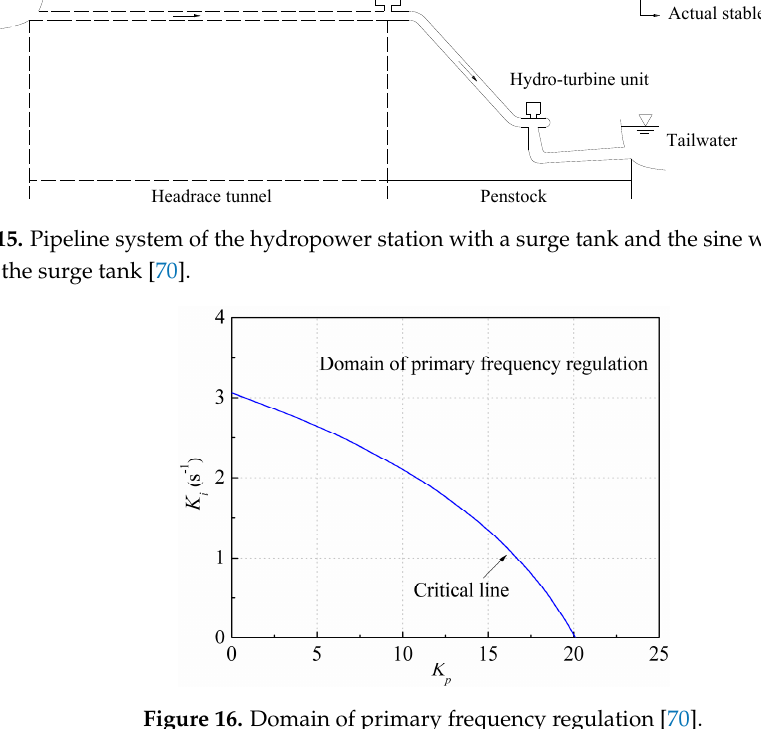
Figure 16. Domain of primary frequency regulation [70].